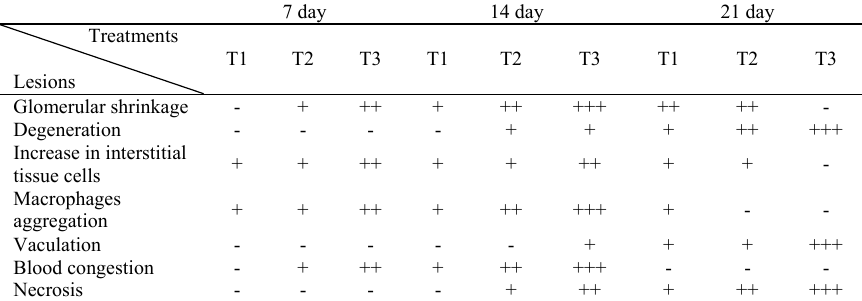
Table 3: Histopathological scores of Caspian roach kidney exposed to continuous exposure of CuNP